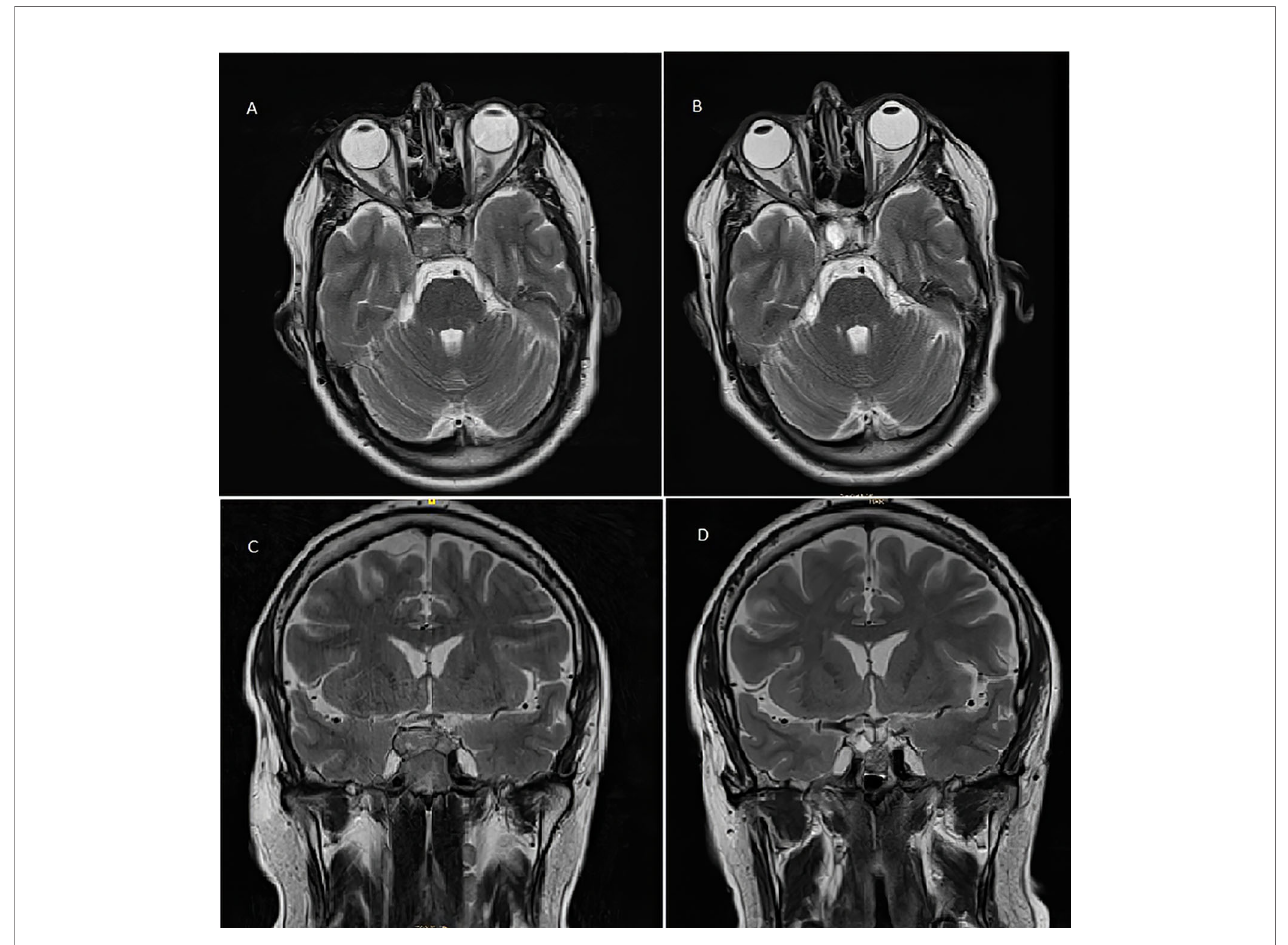
FIGURE 3 | T2-weighted pituitary magnetic resonance imaging before (A, C) and after (B, D) treatment with capecitabine and temozolomide. (A) Pre-CAPTEM axial image. (B) Post-CAPTEM axial image shows a decrease in size of 65% with prominent cystic degeneration. (C) Pre-CAPTEM pituitary coronal image. (D) Post- CAPTEM coronal image shows a decrease in